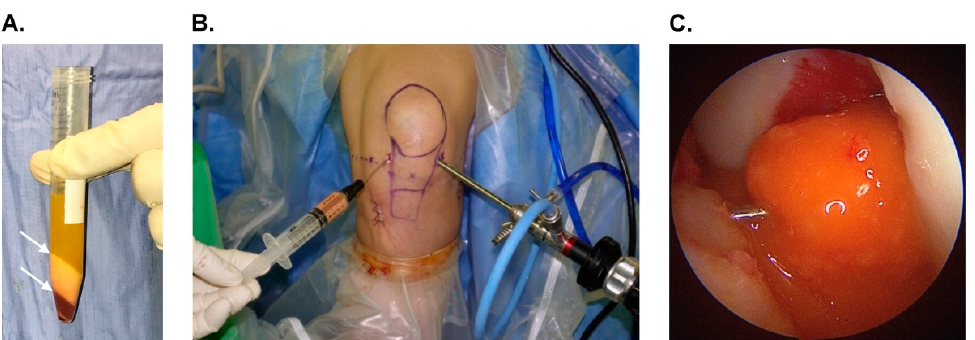
Figure 2. Images showing preparation and administration of adipose stromal vascular fraction (SVF): ( A ) the SVF was the sticky substance under the oil in the tube, which was the yellow layer indicated by two arrows; ( B ) arthroscopic-assisted SVF injection; ( C ) arthroscopic image showing the intrasubstance injection of SVF gel after completing the anterior cruciate ligament reconstruction.